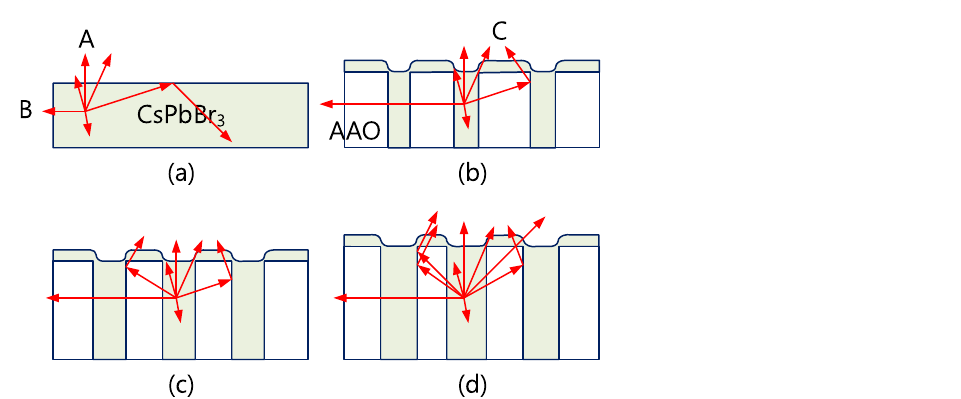
Figure 6. ( a ) Current density, ( b ) luminance, ( c ) current efficiency, and ( d ) external quantum efficiency (EQE) of CsPbBr